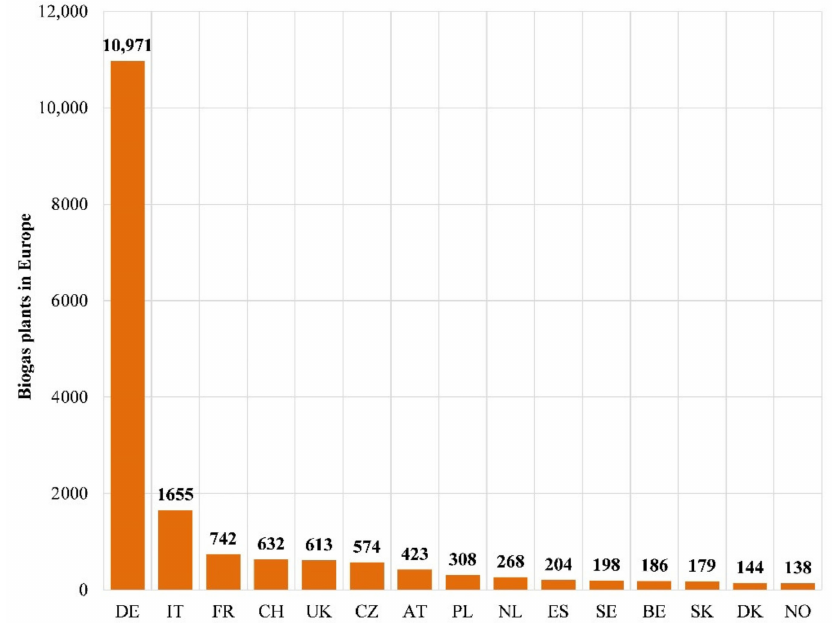
Figure 1. Number of biogas plants in top 15 countries of Europe, arranged in descending